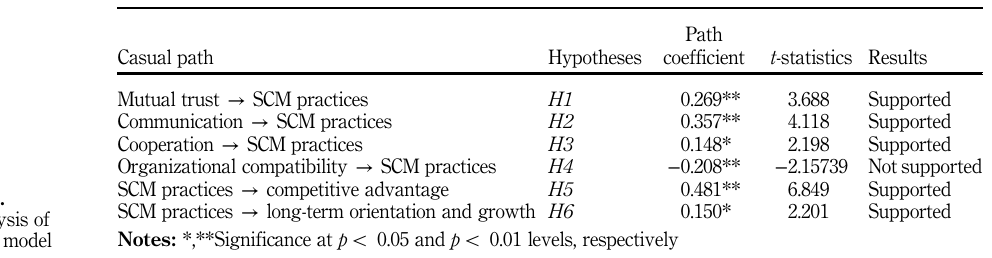
Table VI. Path analysis of structural